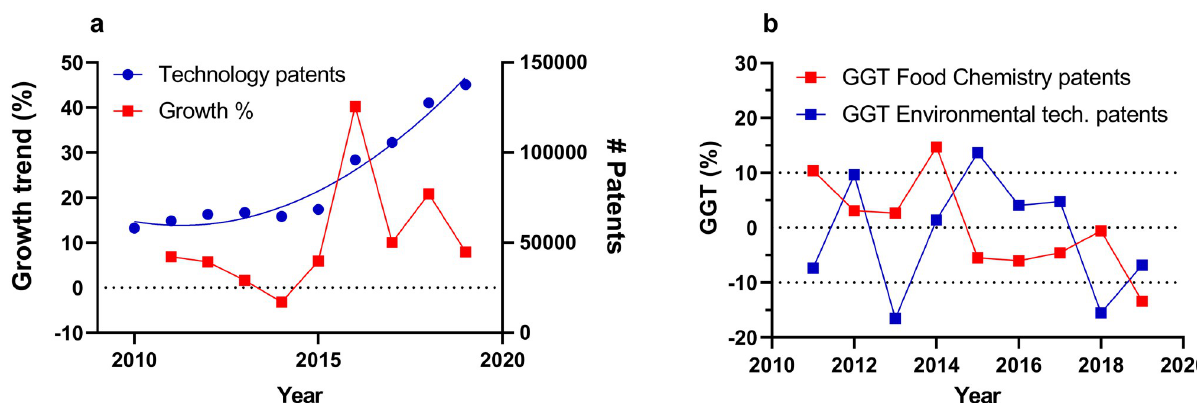
Fig 6. Patent trend analyses. a) Total yearly technology patent output (blue circles; right y-axes) and yearly technology patent output growth rate percentages (red squares, left axes). b) GGTs for food chemistry patents (red squares) and environmental technology patents (blue squares). Patent data was downloaded from the EPO